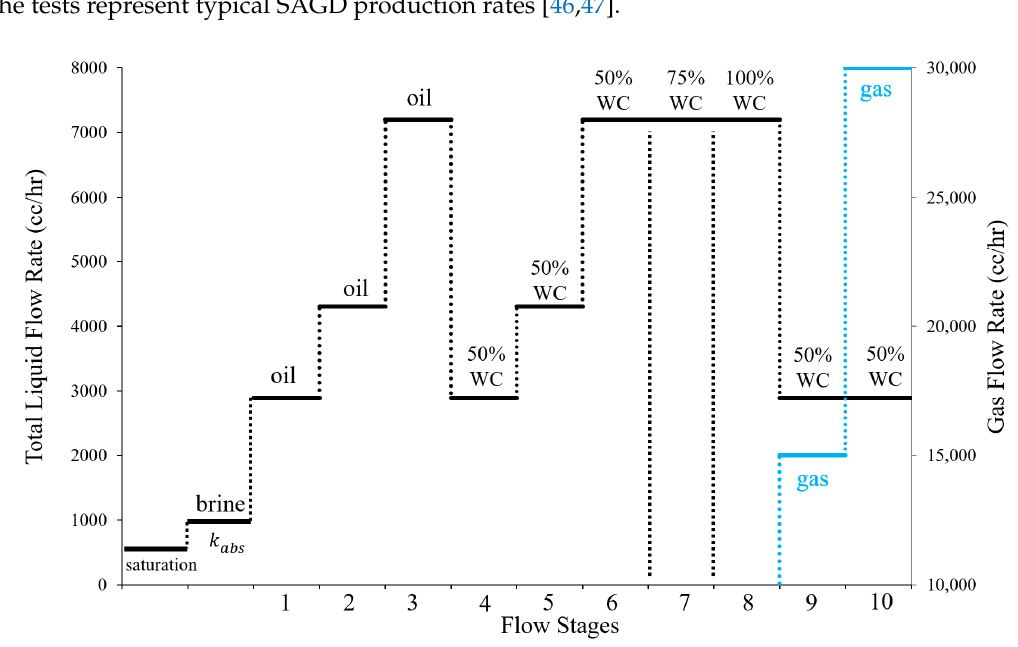
Figure 7. Improved testing procedure design.